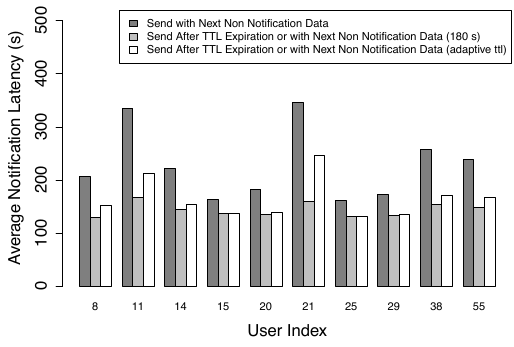
Figure 10: Latency of the Notification Selivery for Each User